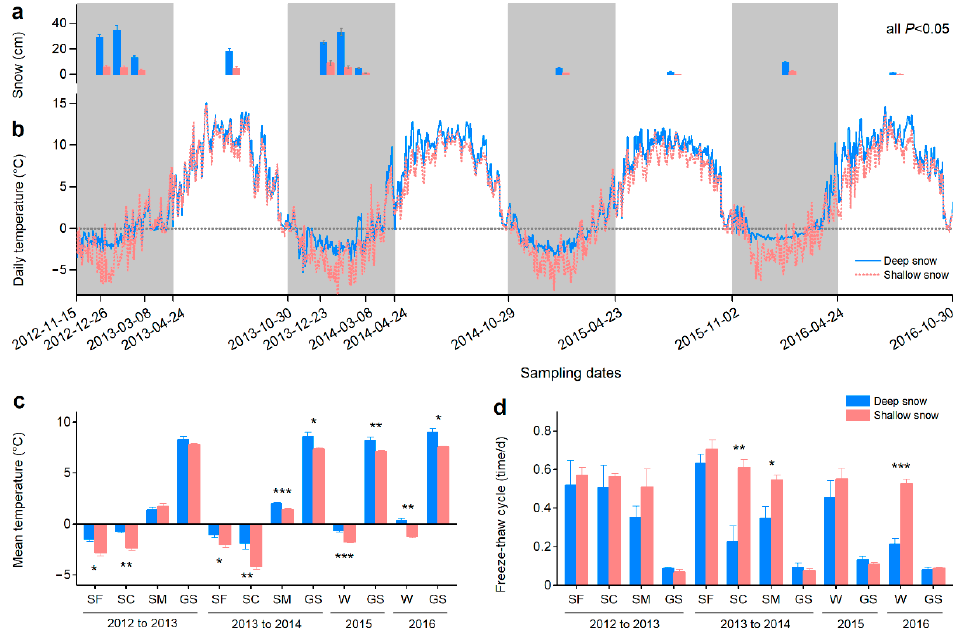
Figure 1. Snow depth, temperature and freeze–thaw cycle. ( a ) Snow depths ( ± SE, n = 18) in deep and shallow snow plots on each sampling date. The samplings were scheduled at the ends of the snow formation, snow coverage and snowmelt stages during winter from 2012 to 2014 (only the snowmelt stages from 2014 to 2016) and at the end of the growing season (beginning of the snow formation stage). The differences between deep and shallow snow plots are significant ( p < 0.05) on all sampling dates. ( b ) Daily temperatures ( n = 6) at the litter surface during the four years of decomposition. Winter times including the snow formation, snow coverage and snowmelt stages are shaded. The dashed line is drawn at the zero value. ( c ) Mean temperatures ( ± SE, n = 6) at individual stages. The times between two adjacent sampling dates were defined as separate stages. ( d ) Freeze–thaw cycles ( ± SE, n = 6) at individual stages. The values were calculated by the quotients of the total number of freeze–thaw cycles and the number of days of certain stages. For panel c and d, the winters in 2015 and 2016 were not divided into snow formation, snow coverage and snowmelt stages. SF: snow formation stage, SC: snow coverage stage, SM: snowmelt stage, W: winter, and GS: growing season. * p < 0.05, ** p < 0.01 and *** p <